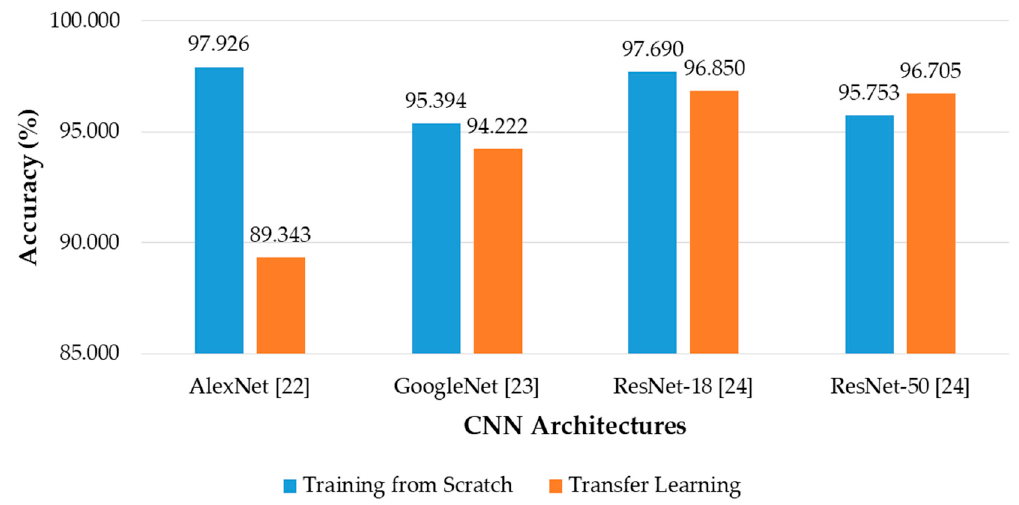
Figure 10. Average accuracy of banknote type and fitness classification using various CNN architectures with training from scratch and transfer learning.